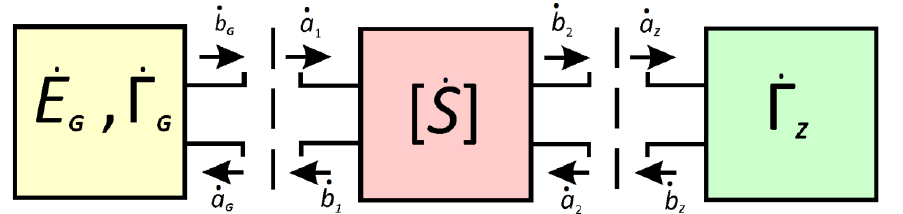
Figure 1. Schematic diagram of measuring system for electrical length of the transmission path.